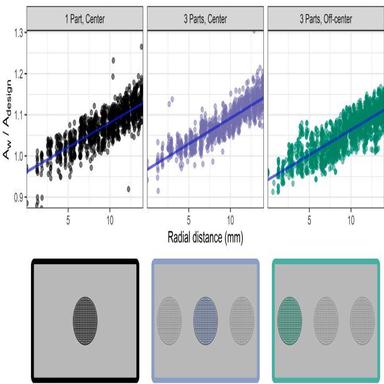
Dimensional characterization of the three lattice configurations (n = 3 replicates per configuration).